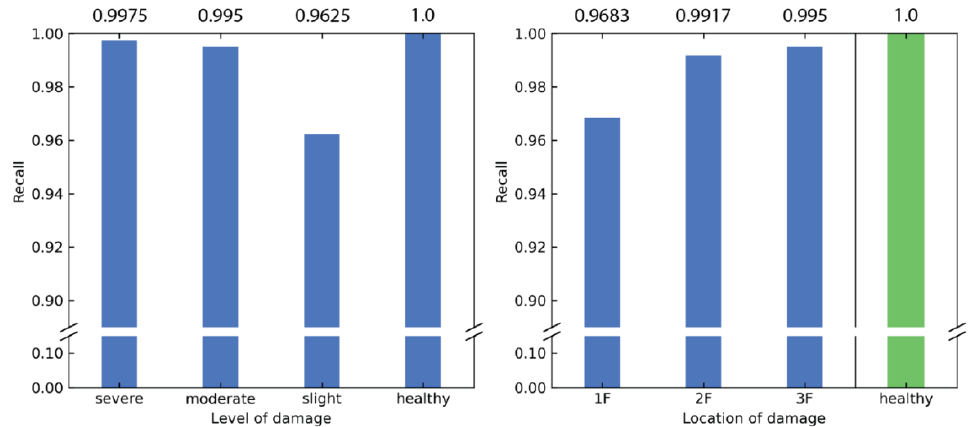
Figure 8. Recall calculated based on level of damage and the location of damage.